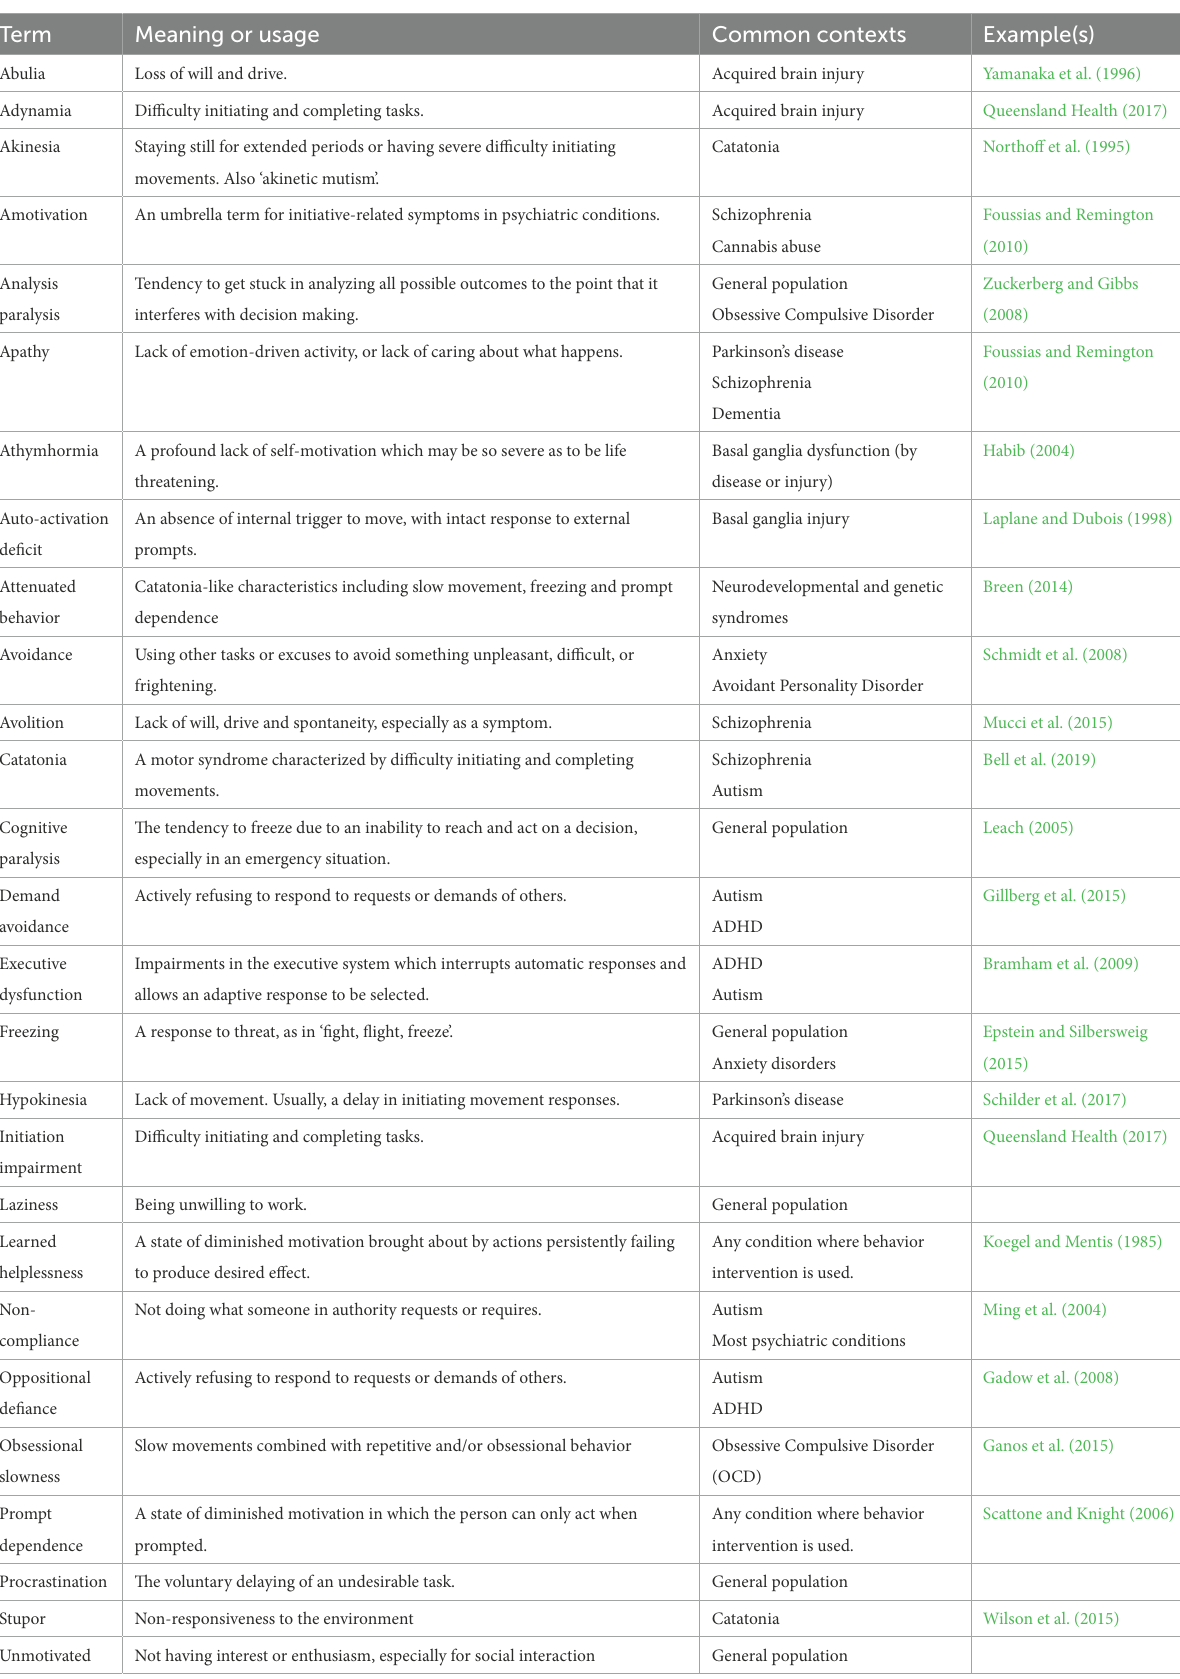
TABLE 1 Terms for initiation impairments across clinical and non-clinical